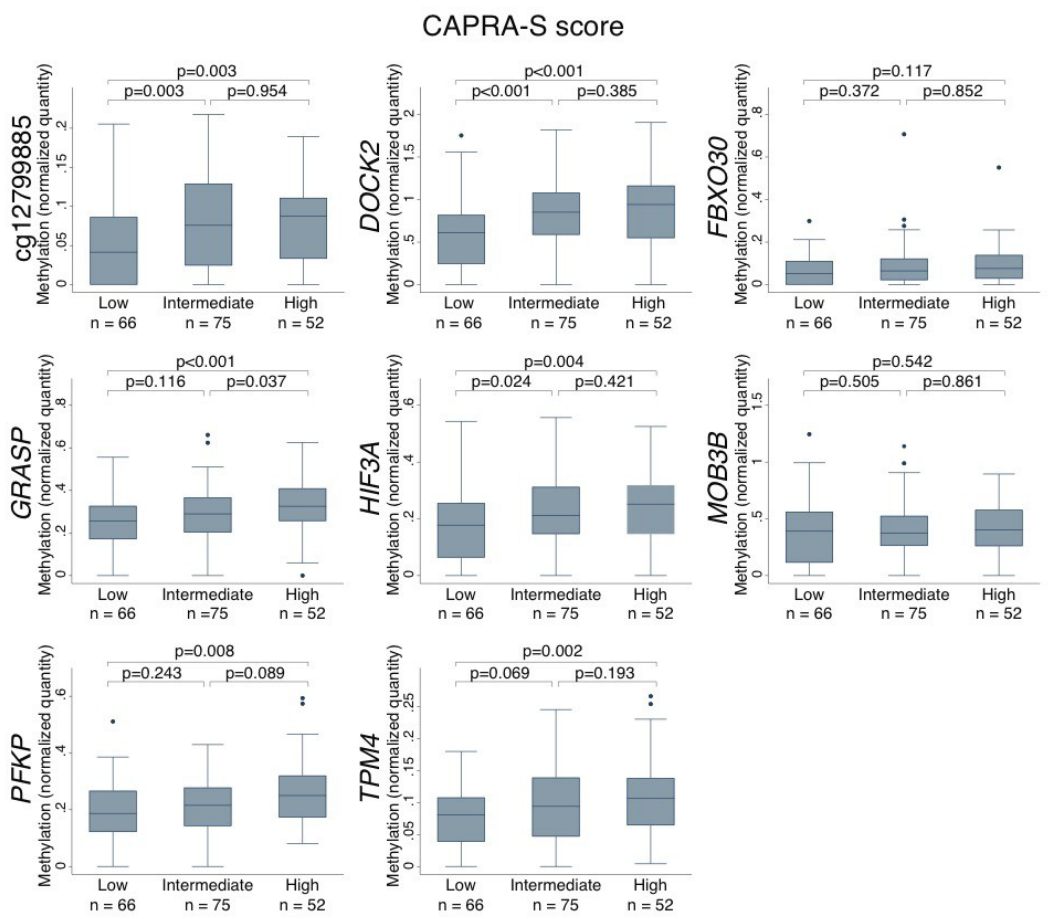
Figure 5. Box plots show the DNA methylation levels (normalized to ALUC4 ) for each top candidate marker as compared to the CAPRA-S risk score. CAPRA-S scores ranged from 0–2 (low), 3–5 (intermediate) and ≥ 6 (high). p -value, Wilcoxon Mann–Whitney test. The colored boxes indicate the 25–75th percentiles and the black lines indicate the median. The top whiskers are the 3rd quartile + 1.5 interquartile range and the bottom whiskers are the 1st quartile–1.5 interquartile range. Dots indicate outliers.